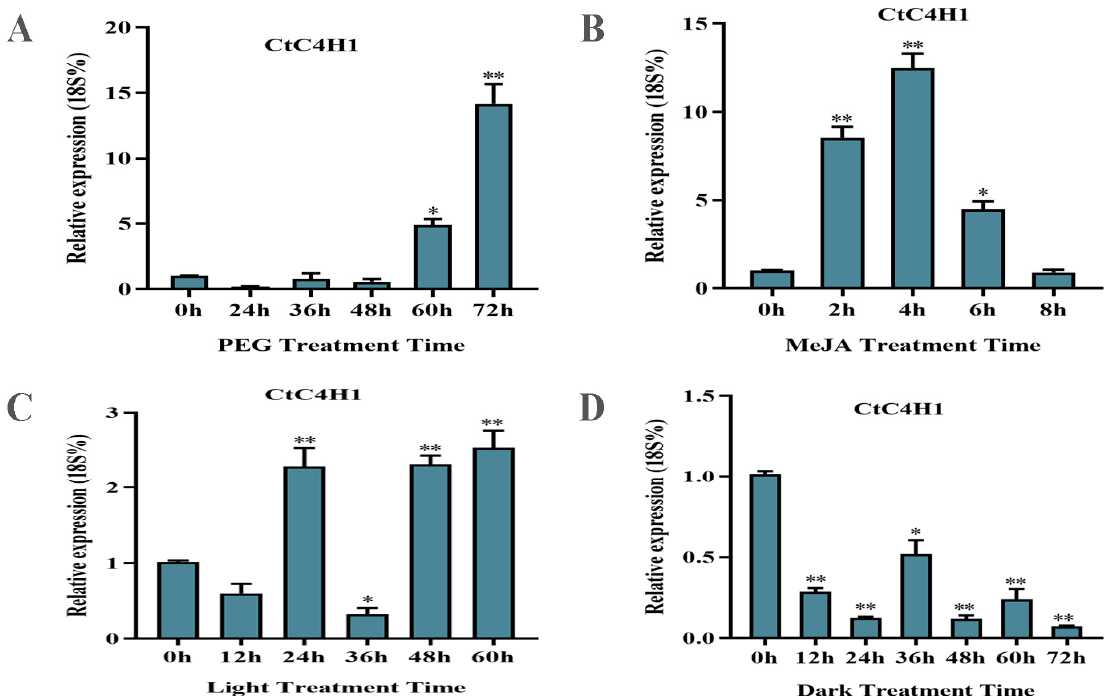
Figure 6. Expression analysis of CtC4H1 gene under different abiotic stress conditions. ( A ) PEG treatment. ( B ) MeJA treatment. ( C ) Light treatment and ( D ) dark treatment. The relative expression level was normalized with 18S rRNA gene which was used as housekeeping gene. The numerical value represents the average ± standard deviation of three biological repetitive samples. The statistics were calculated with one-way ANOVA test and significant differences between treatments were demonstrated with asterisk (* p < 0.05, ** p < 0.01).